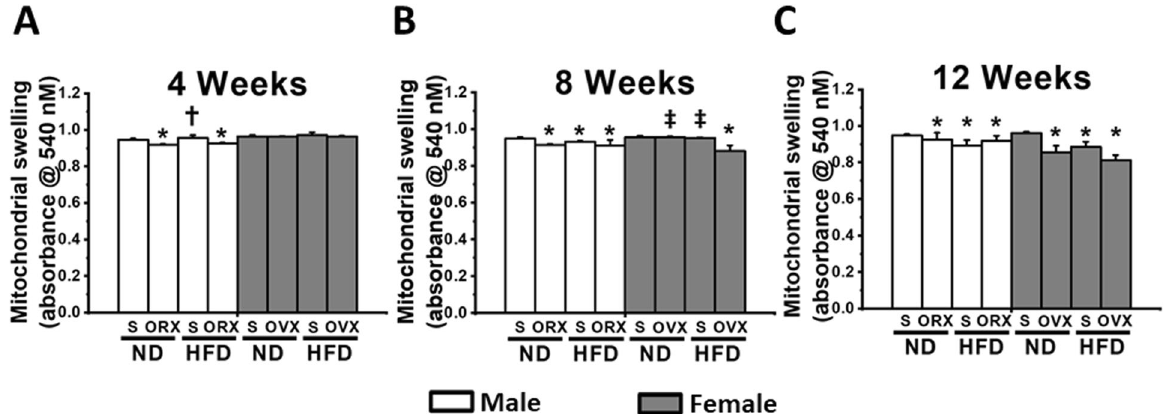
Fig. 5 The effect of sex hormone and dietary consumption on cardiac mitochondrial swelling at different time courses (4, 8, and 12 weeks). A The cardiac mitochondrial swelling at 4 weeks. B The cardiac mitochondrial swelling at 8 weeks. C The cardiac mitochondrial swelling at 12 weeks. * P < 0.05 vs sex-matched ND-Sham ( n = 6/group). * P < 0.05 vs sex-matched ND-Sham ( n = 6/group). † P < 0.05 vs male orchiectomized rats ( n = 6/group). ‡ P < 0.05 vs female high-fat diet-fed ovariectomized rats ( n = 6/group). S sham, ND normal diet, HFD high- fat diet, ORX orchiectomized rats, OVX ovariectomized